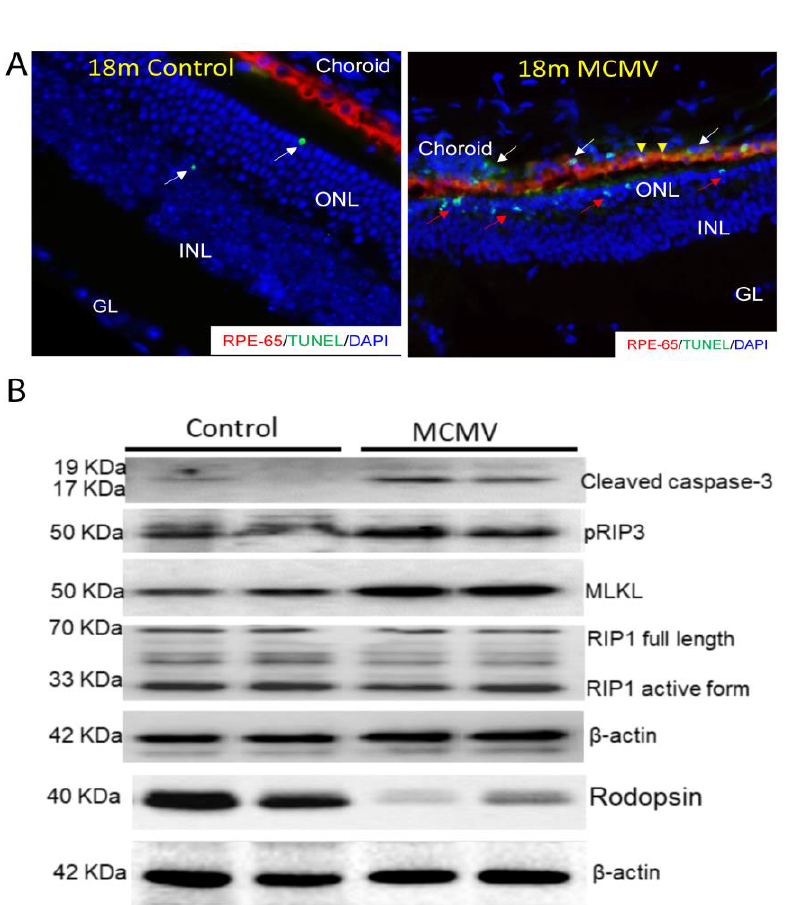
Figure 3. ( A ) Representative merged photomicrograph of staining for RPE-65 (red), TUNEL (green), and DAPI (blue) in eyes of latently infected mice at 18 months p.i. (MCMV) together with age- matched control eyes (control). ( B ) Western blot stained with antibodies against cleaved caspase 3, pRIP3, MLKL, RIP1, Rodopsin, and β -actin in eyes of latently infected mice at 18 months p.i. (MCMV) together with age-matched control eyes (control).